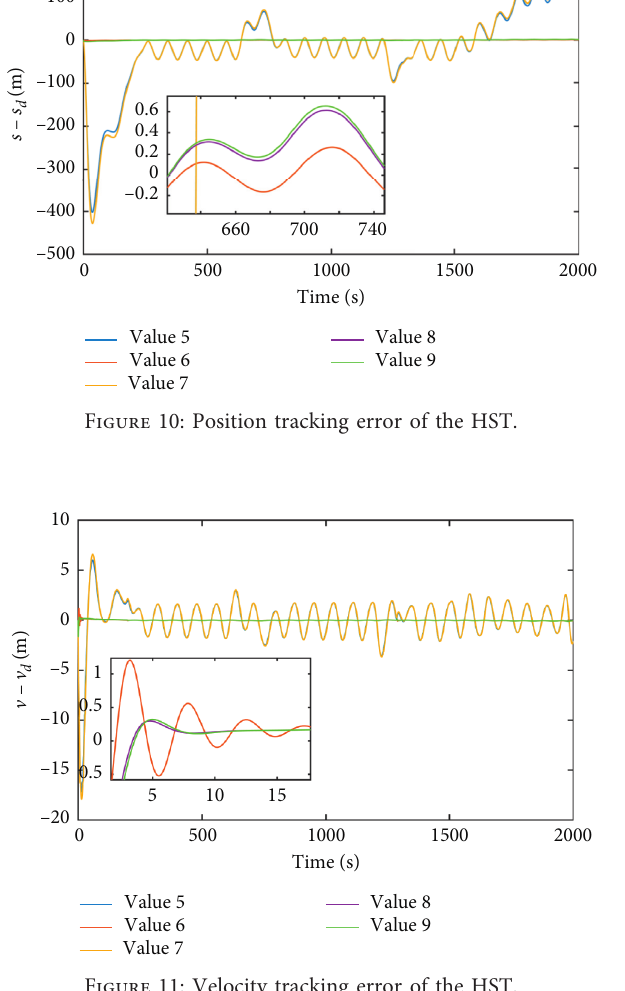
Figure 11: Velocity tracking error of the HST.